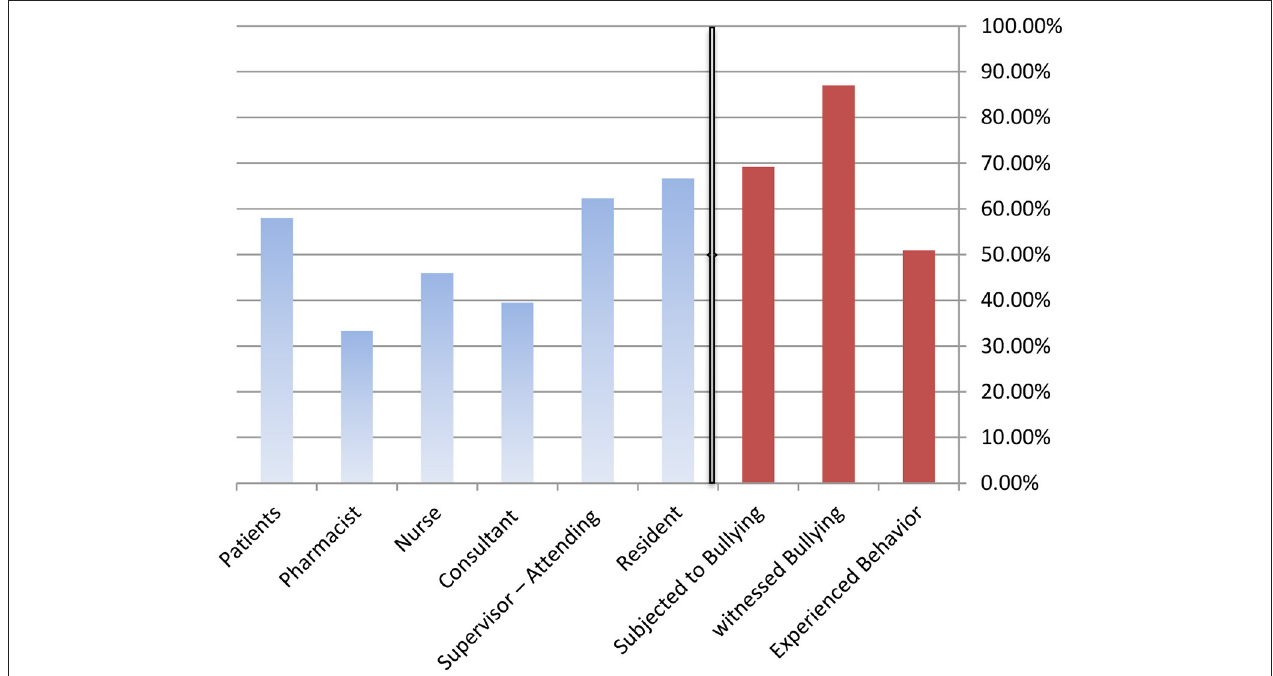
FIGURE 1 | Percentage of participants who experienced bullying behaviors, witnessed bullying of colleagues, or were subjected to bullying themselves, and the source of that